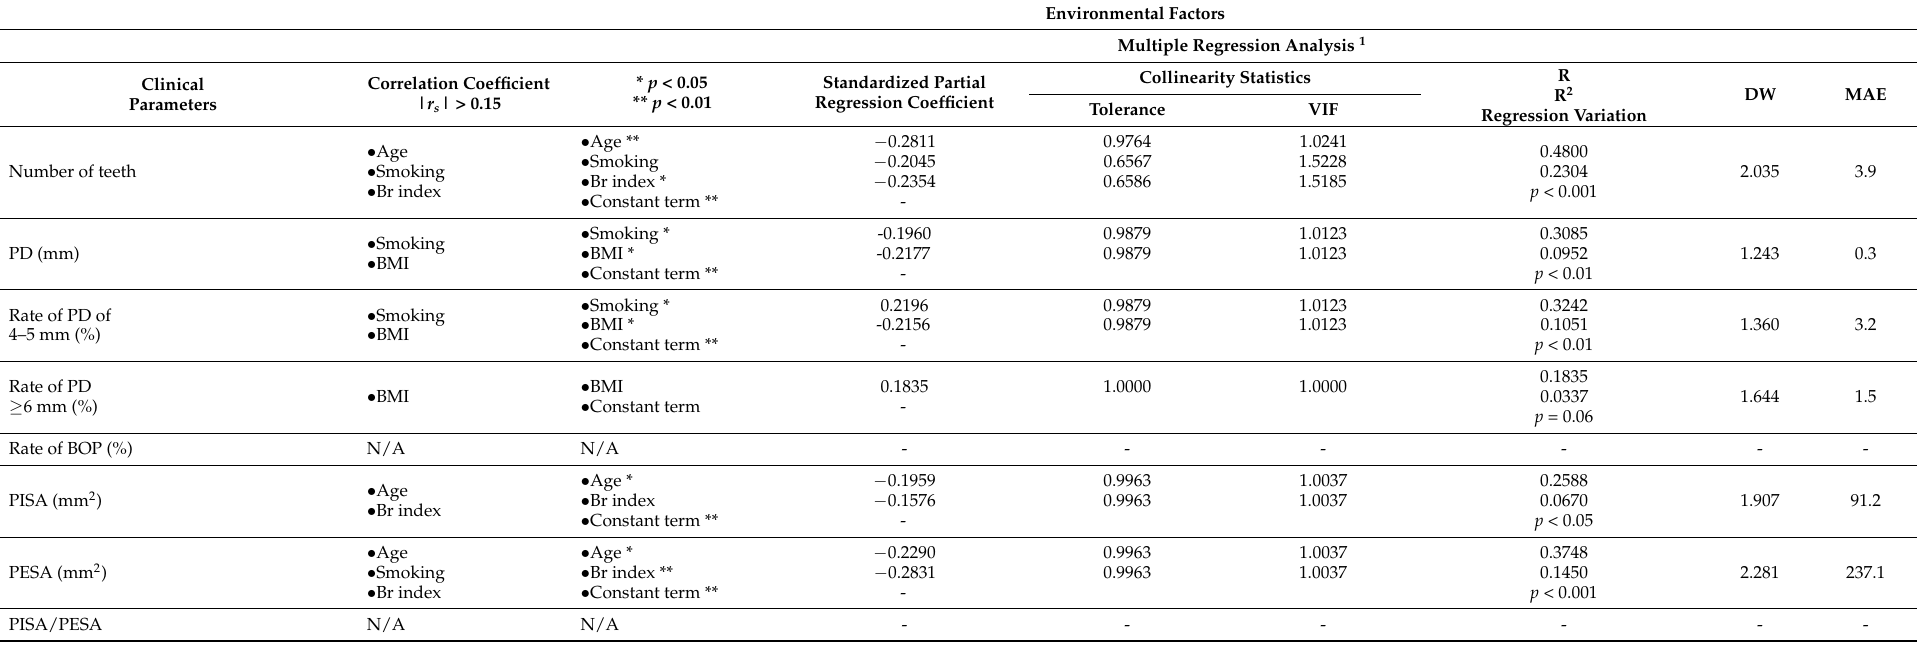
Table 1. Multiple linear regression analysis to predict clinical parameters based on environmental